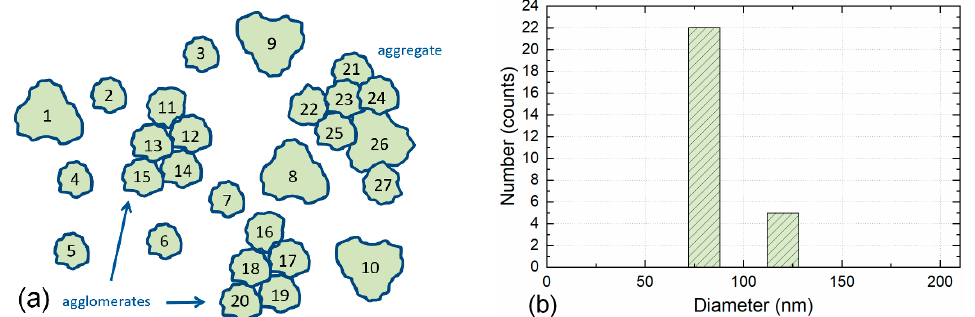
Figure 5. Illustration of Counting Rule 4. ( a ) The particles 1 to 10 are counted as individual particles. The integral components of the two agglomerates are counted as particles 11 to 15 and 16 to 20. In the aggregate the integral components are counted as particles 21 to 27. This results in a total count of 27 particles. ( b ) Note the shift of the PSD to lowest size values. The height of the two columns in the histogram reflects the number of particles of the two sizes 80 nm (22 particles) and 120 nm (5 particles). The width of the columns has no quantitative relevance and is only illustrative.